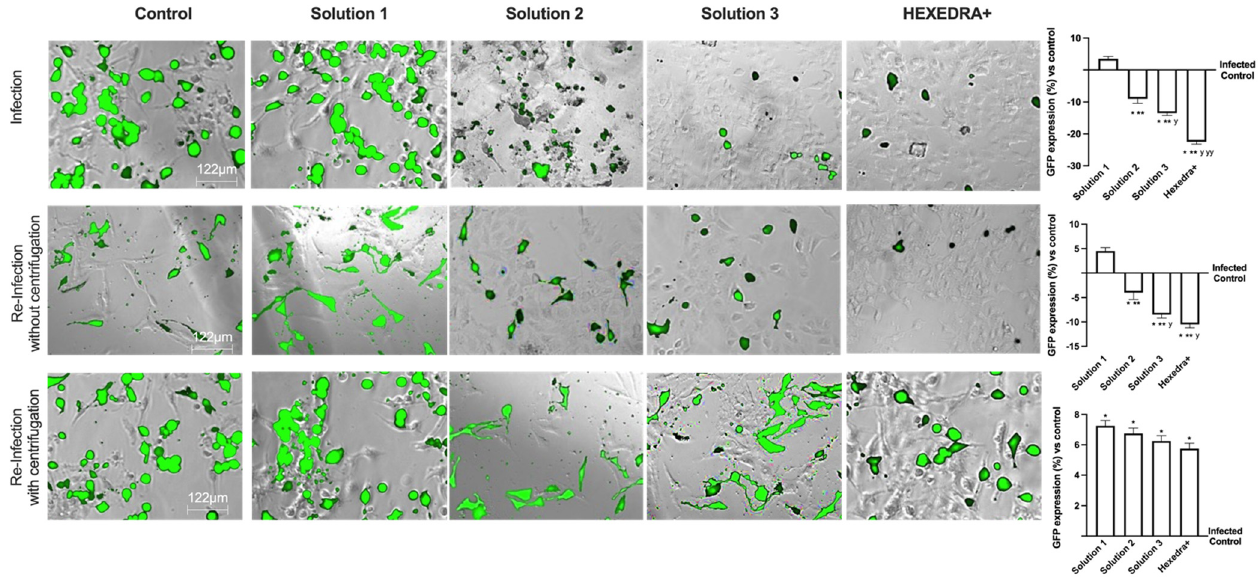
Figure 3. Analysis of infection of Vero E6 cells with VSV-based pseudovirus SARS-CoV-2 (MOI 0.1) pre-treated with the different UA-based formulations. The images reported were an example of each stimulation for GFP fluorescence expression obtained at 40× magnification by Paula (Leica DM1000). The positive cells were counted analyzing GFP expression in cells by the Image J software and the results were expressed as mean ± SD (%) compared to infected control cells (0 line) of four independent experiments. The abbreviations are the same reported in Figure 2. * p < 0.05 vs. infected control; ** p < 0.05 vs. Solution 1; y p < 0.05 vs. Solution 2; yy p < 0.05 vs. Solution 3.